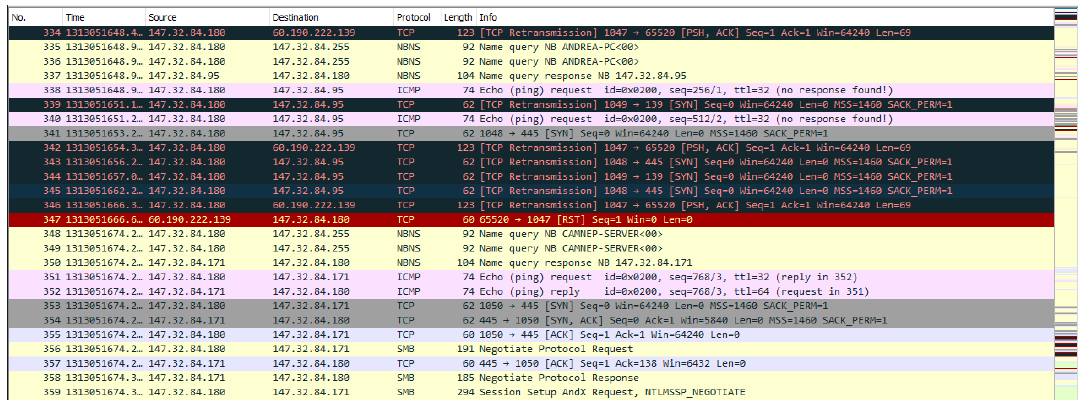
Figure 9. Network traffic captured with Wireshark.